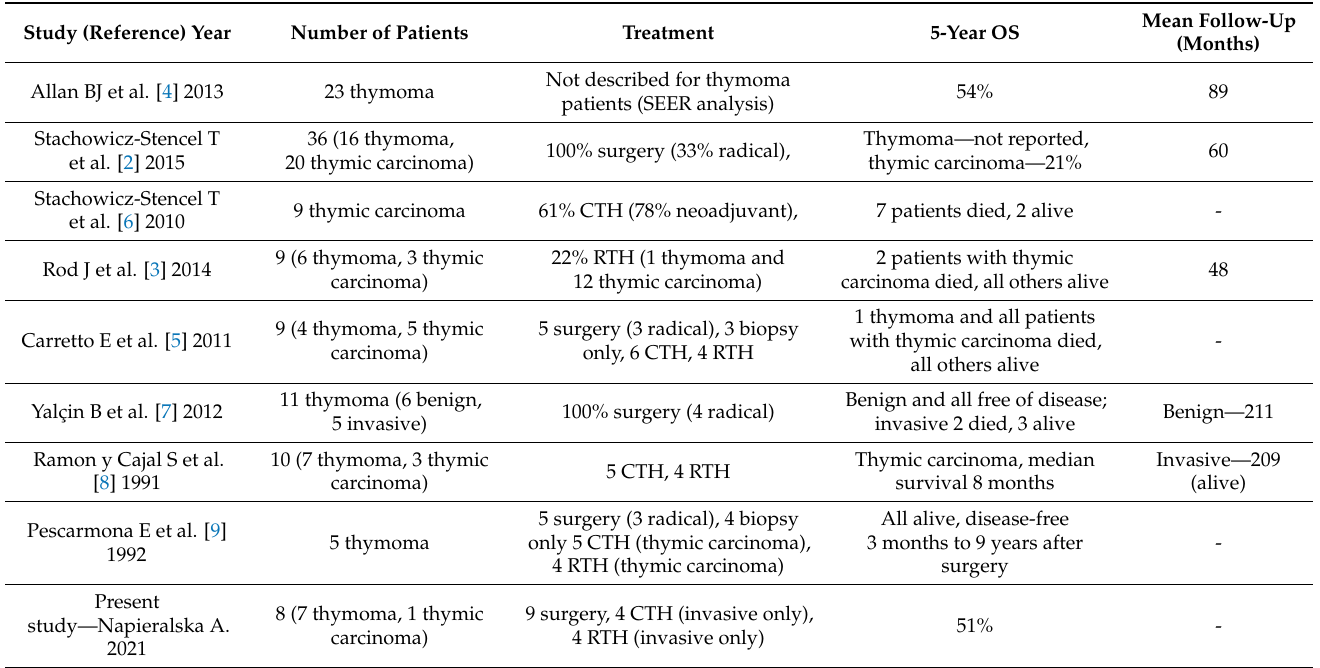
Table 5. Thymoma and thymic carcinoma